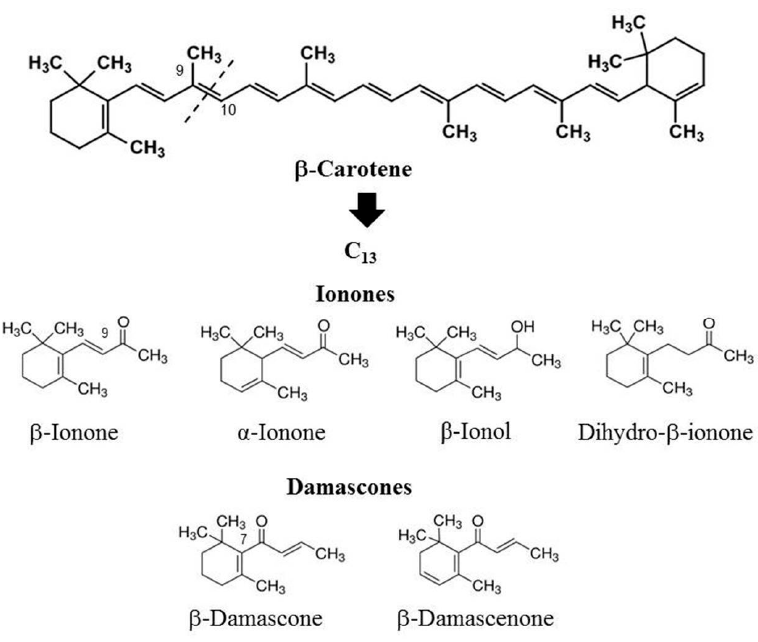
Figure 1. Carotenoid-related compounds in the study.